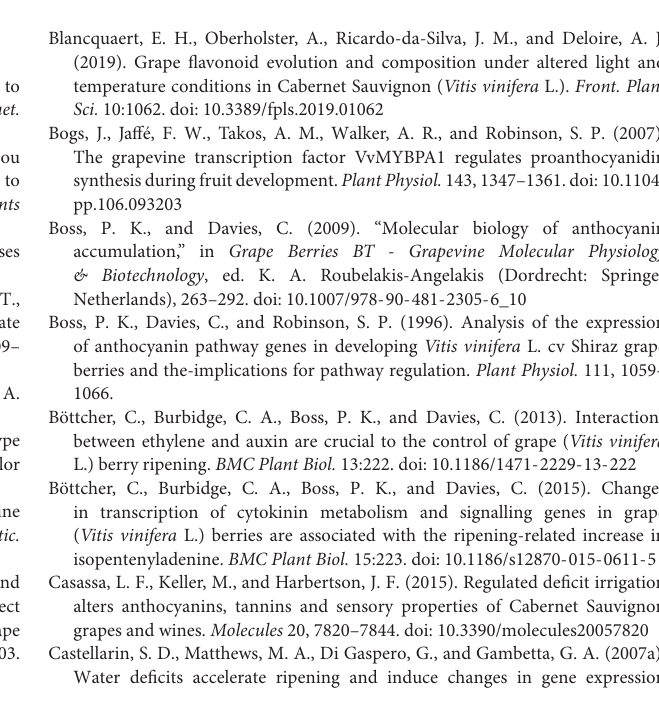
Supplementary Table 2 | Primers for genes used for